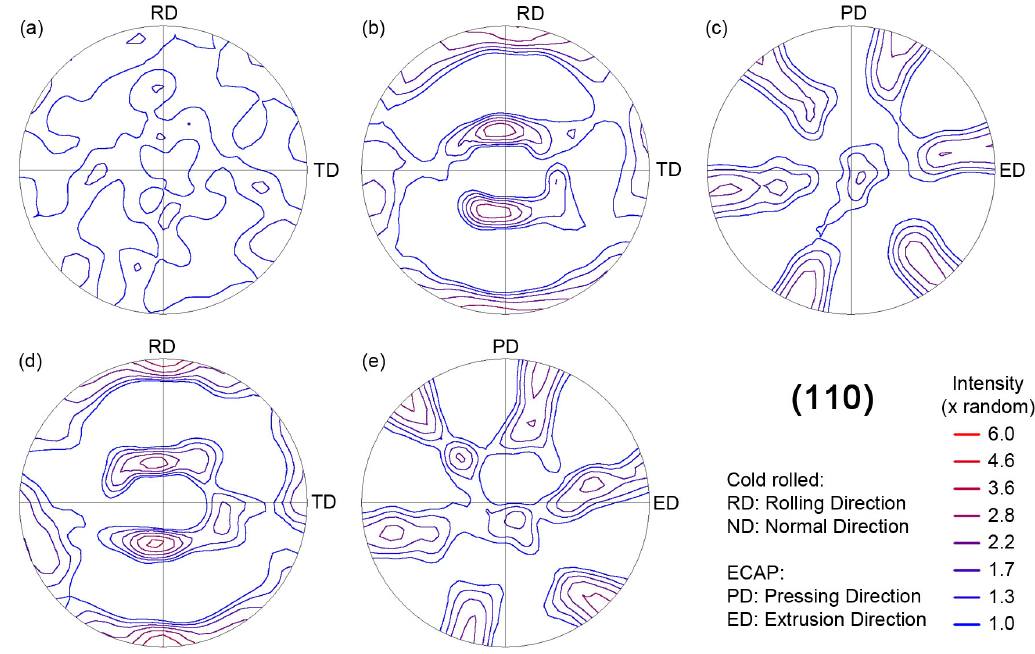
Figure 3. (110) pole figure maps for ARMCO ® iron ( a ) as-received; ( b ) after cold rolling to 64% rolling reduction; ( c ) after one ECAP pass; ( d ) after one ECAP pass followed by cold rolling to 64% rolling reduction; ( e ) after five ECAP passes along route B C .